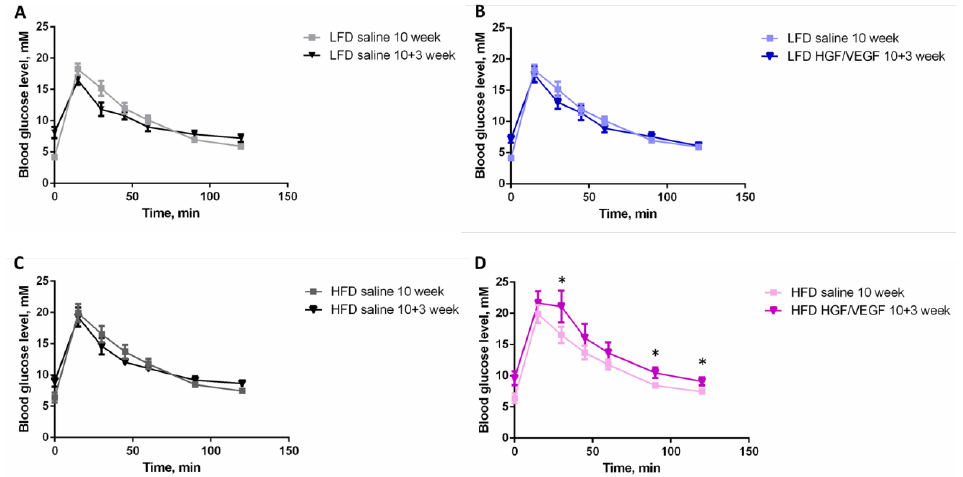
Figure 2. HGF/VEGF plasmid injection impairs glucose tolerance compared to pre-surgery state. ( A ) GTT curves for LFD group on 10 and 10 + 3 weeks of experiment; ( B ) GTT curves for LFD HGF/VEGF group on 10 and 10 + 3 weeks of experiment; ( C ) GTT curves for HFD group on 10 and 10 + 3 weeks of experiment; ( D ) GTT curves for HFD HGF/VEGF group on 10 and 10 + 3 weeks of experiment. Abbreviations: LFD, low fat diet; HFD, high fat diet; FBG, fasting blood glucose; GTT, glucose tol- erance test. Data is presented as mean ± SEM, Mann – Whitney U-test; * p < 0.05.